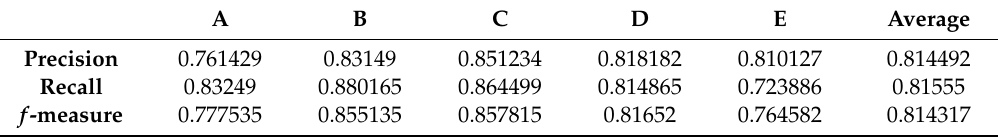
Table 5. Precision, Recall, and f -measure values of each class.